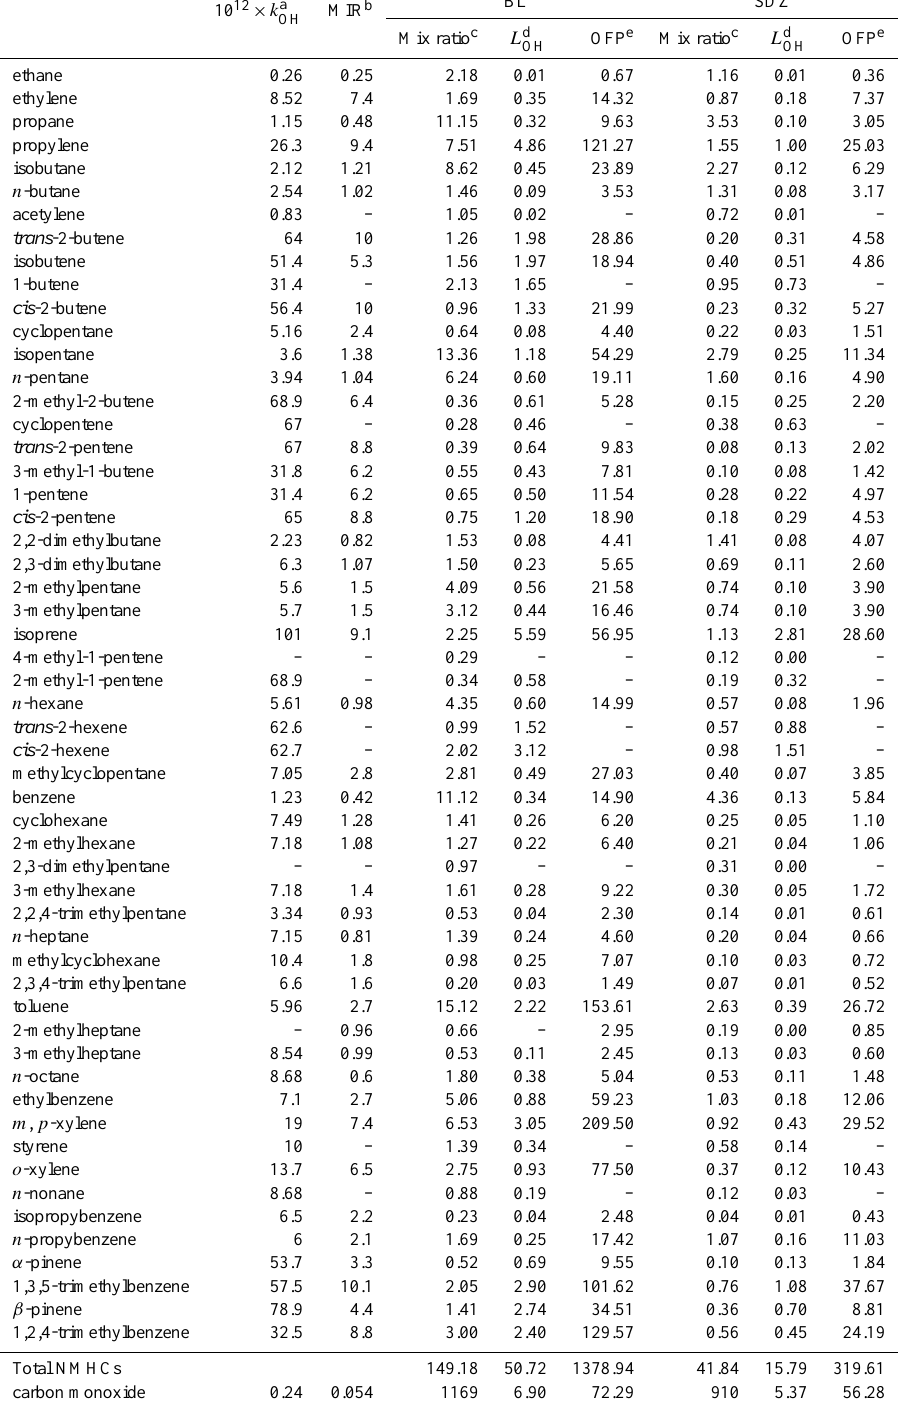
Table 3. Chemical characteristics of NMHCs and CO at the BL and SDZ